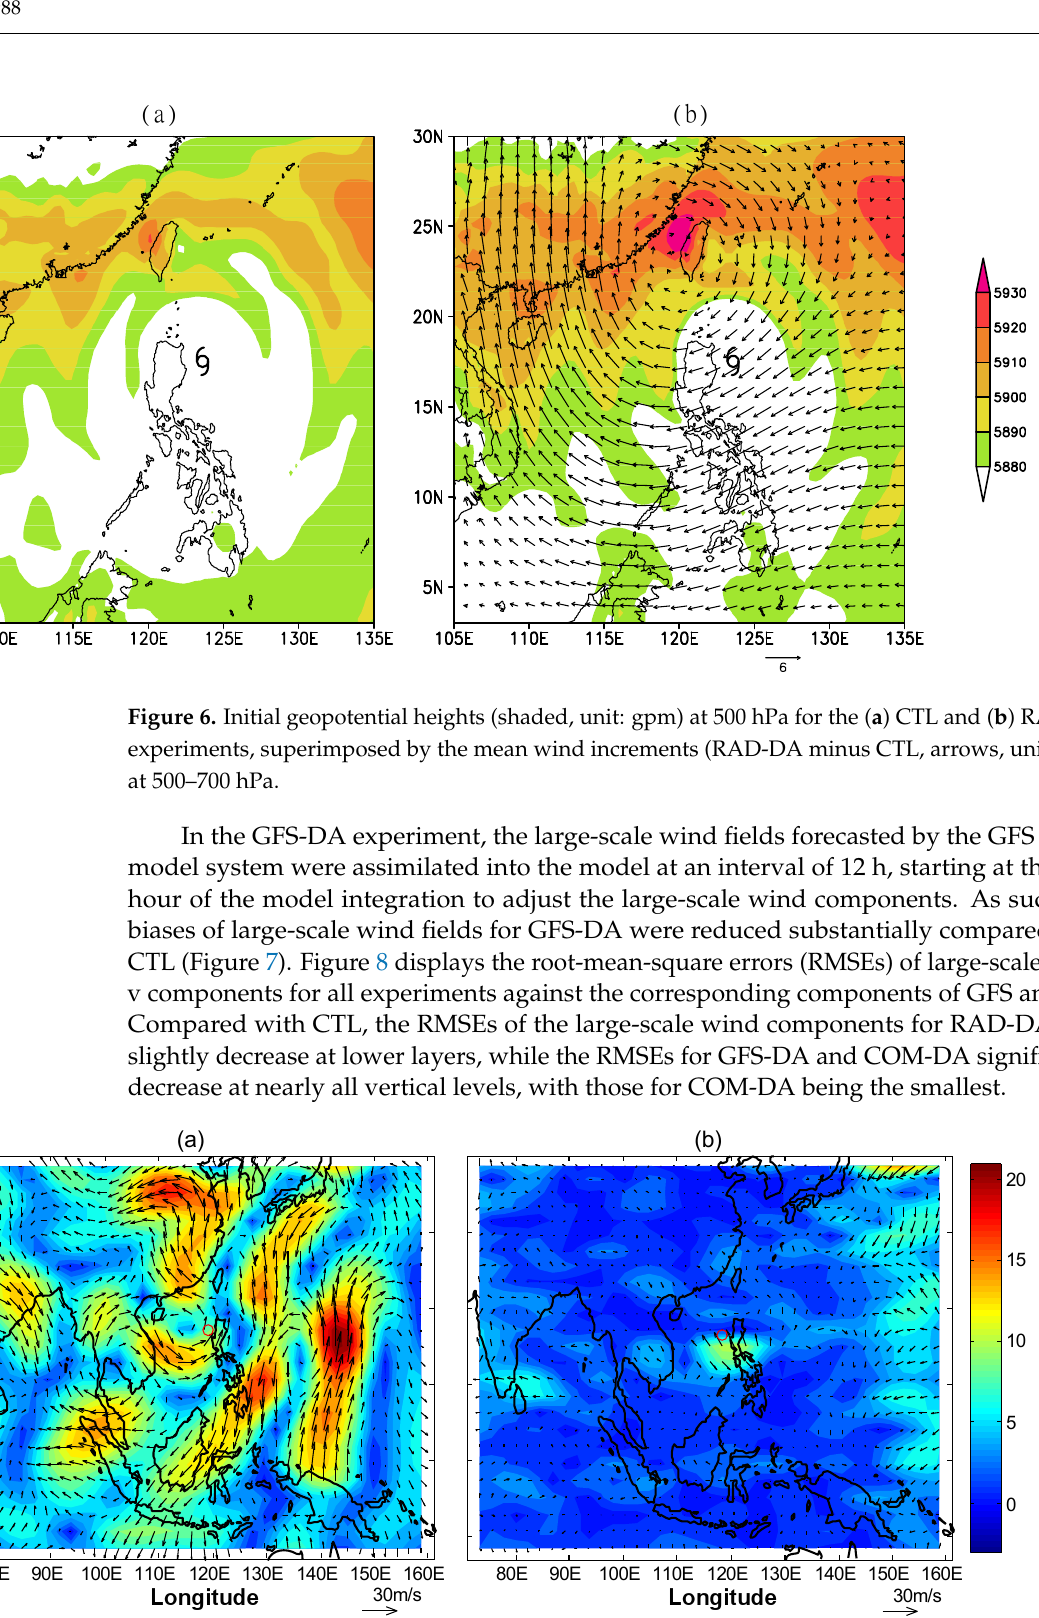
Figure 5. Initial temperature (shaded, unit: K) and temperature increment (RAD ‐ DA minus CTL, contour, unit: K) at 200 hPa, 500 hPa, 700 hPa, and 850 hPa for the RAD ‐ DA experiment.